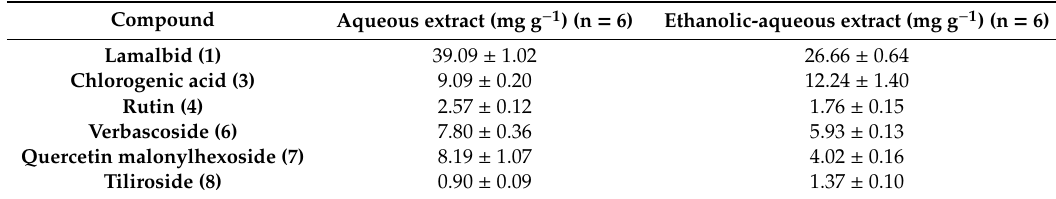
Table 2. Contents of the tested compounds in aqueous and ethanolic-aqueous extracts from Lamium album flowers (mg g − 1 d.w. of